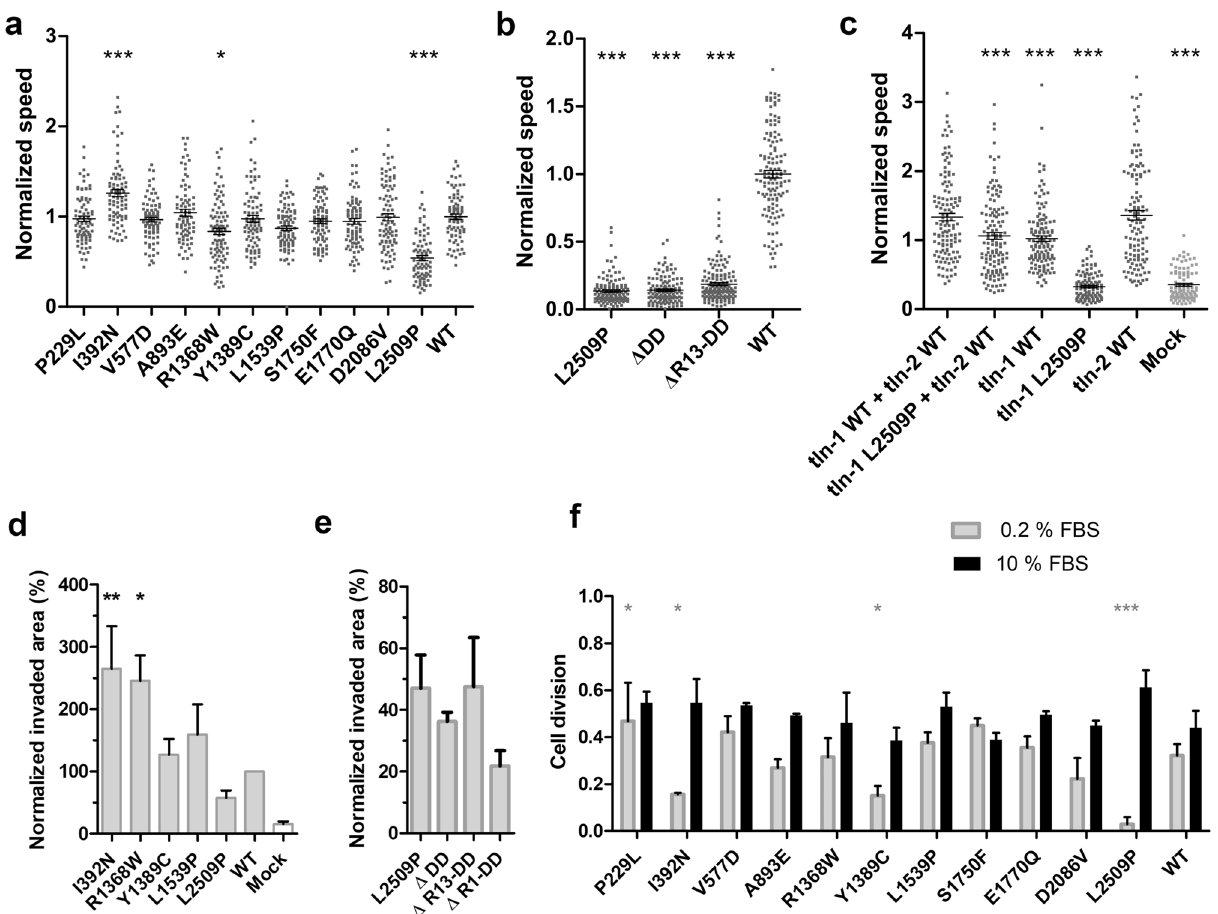
Figure 7. Talin mutations affect cell migration and proliferation. ( a ) Random migration speed (µm/min) determined from time-lapse images of talin expressing cells. ( b ) Migration speed on 2D surface showing reduced migration speed in all mutated/truncated constructs in comparison to WT. ( c ) Migration assay on 2D surface showing reduced migration speed in cells co-transfected with talin-1 L2509P and full-length WT talin-2. The statistical significance of all results analysed in comparison to talin-1 WT + talin-2 WT by one-way ANOVA and Bonferroni test: *P < 0.05, **P < 0.01, ***P < 0.001. The results are normalised with talin-1 WT. ( d ) Invasion assay through Matrigel matrix towards 10% FBS containing medium. Control cells were mock-transfected with GFP-expressing plasmid. The values are normalised to WT and statistical significance measured in comparison to WT. Data are mean + /–SEM. The statistical significance was analysed by one-way ANOVA and Bonferroni test: *P < 0.05, **P < 0.01, ***P < 0.001. ( e ) Cell invasion through Matrigel in 3D environment showing the invasiveness potential of the L2509P and truncated talin constructs. Invasion assay was repeated at least three times in triplicate chamber for each construct on separate days. ( f ) Cell proliferation analysis in the presence of 10% FBS and 0.2% FBS, showing the number of times the cells divide in 12 h; n ~ 80 cells per mutation from four separate experiments. The statistical analysis was calculated by t-test, non-parametric test of Mann–Whitney: *P < 0.05, **P < 0.01, ***P < 0.001 compared to WT for each